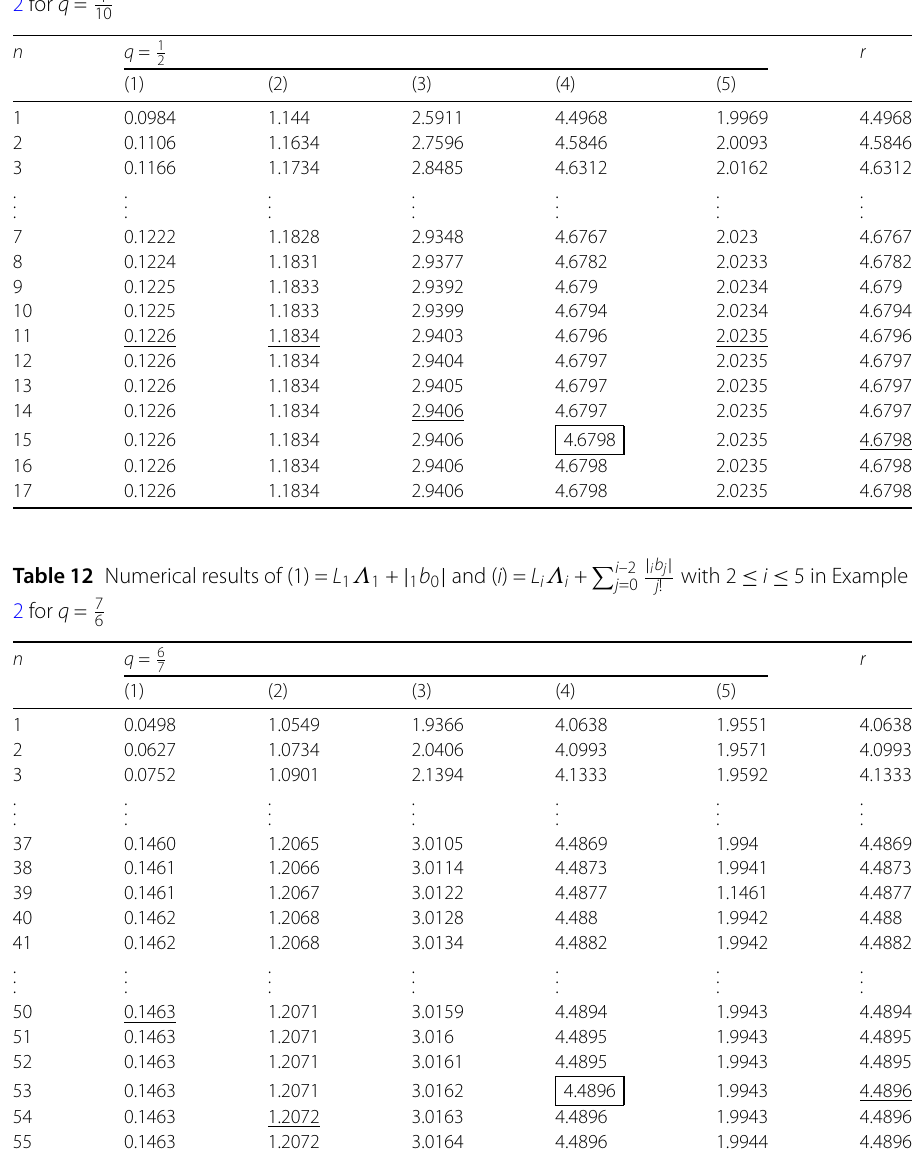
(cid:7) | i b j | i –2 with 2 ≤ i ≤ 5 in Example j =0 j !